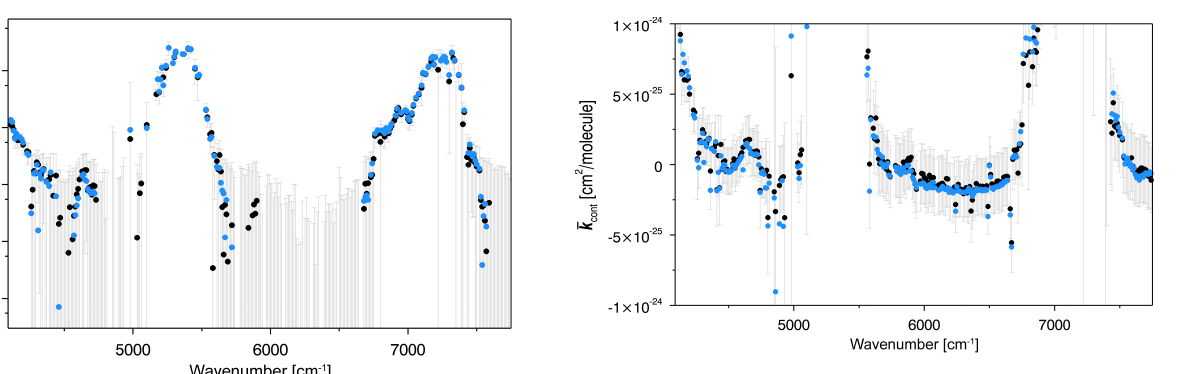
Figure 4. Same as Fig. 3 but using a linear scale to show the results in the window